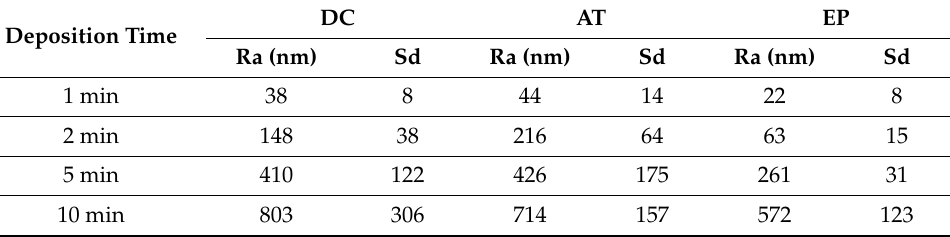
Table 3. Coatings’ average roughness (Ra) according to the treatments performed and deposition times (DC-Detergent cleaning, AT-Acid treatment,